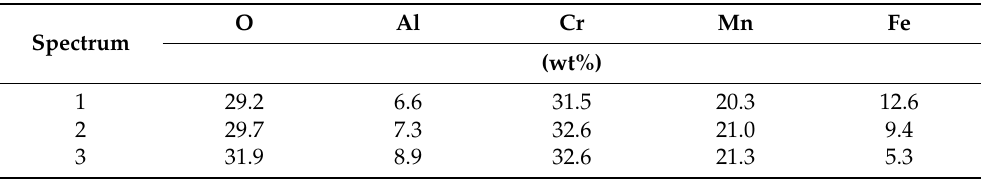
Figure 5. Microstructure of chromium sample 7 ( A – D ) with lower carbon content and sample 8 ( E – H ) with higher carbon content; left column—initial state, right column—remelted state; ( A , B , E , F )—light microscopy, ( C , D , G , H )—scanning electron microscopy. Locations where EDX spot microanalysis was performed (inlay of Figure 6B). Table 4. EDX point analysis of oxide inclusions of sample